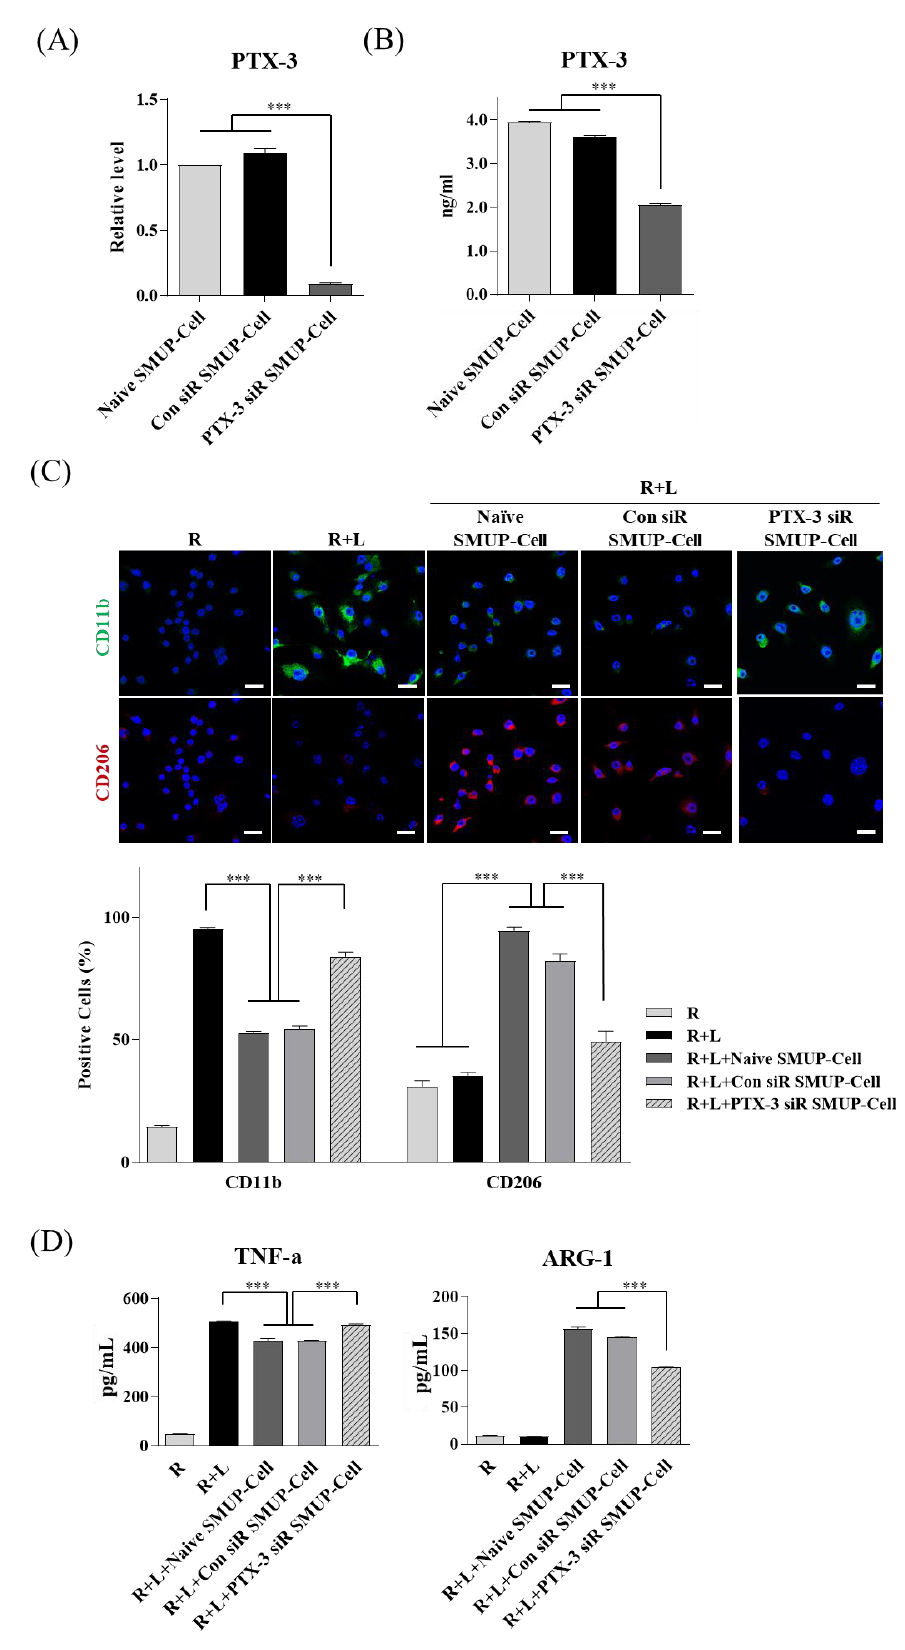
Figure 5. PTX-3 silencing in SMUP-Cells accelerates macrophage polarization. Raw 264.7 cells were exposed to LPS and then co-cultured with SMUP-Cells for 2 days. SMUP-Cells were transfected with control siRNA or PTX-3 siRNA before co-culture. ( A ) Gene expression and ( B ) secreted protein levels of PTX-3 were compared relative to those in non-transfected